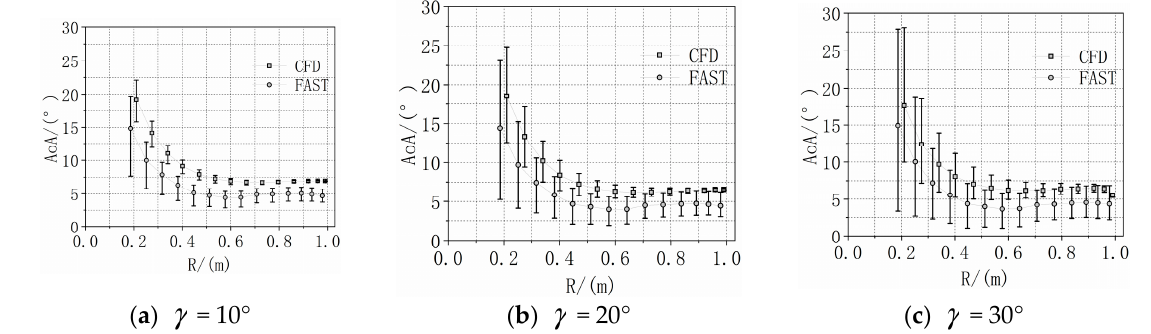
Figure 9. The profile of AOA along the blade span under yawed cases.